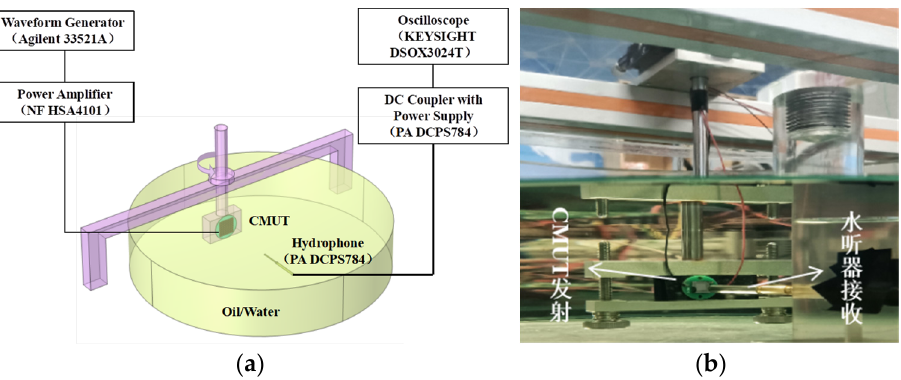
Micromachines 2022 , 13 , x FOR PEER REVIEW Figure 14. Frequency response function of the CMUT with and without coating. Figure 14. Frequency response function of the CMUT with and without coating.